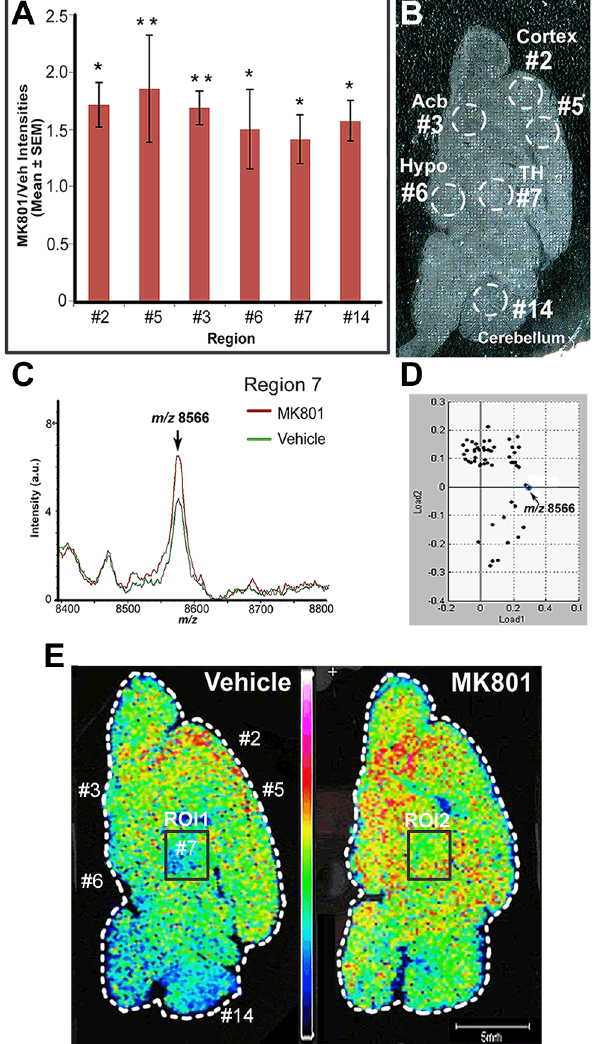
Figure 3. Elevated level of the m/z 6718 ion quantified by the strategy combining MS profiling and imaging. A) The ratios of the intensities of the ion at m/z 6718 in the profiling spectra of specific regions, regions # 1, # 2, # 5, # 9, # 7 and # 14, where the ion was concentrated. The averaged intensities and p-values were calculated by ClinProTools and manually confirmed. *, p , 0.05; **, p , 0.01, unpaired student’s t-test. (B) An optical image of a rat brain section washed after MSI experiments. (C) The m/z 6718 ion was up-regulated in the averaged MSI spectrum of the olfactory bulbs, ROI 1 and ROI2, of the rat brain section treated with vehicle and MK801 as shown in (E). (D) A loading plot of ROI 1 and ROI 2 analyzed by ClinProTools. The m/z 6718 ion was shown to contribute significantly in differentiating the two ROIs in Load 2. (E) MS images of the ions at m/z 6718 for the vehicle and the MK801-treated rat brain sections. The m/z 6718 ion was more concentrated in the olfactory bulb, cortex, thalamus (TH) and cerebellum regions in the MK801-treated section compared to the vehicle-treated one. doi:10.1371/journal.pone.0092831.g003 fulfilled by the conventional fractionation, which helped eliminat- ing ion suppression effects, reducing sample complexity and thus increasing the dynamic range of the analysis. The rat brains were pooled and fractionated in RP HPLC to concentrate the targeted proteins and reduce the complexity arising from high abundance proteins of tissues. All fractions were then screened on MALDI- TOF/TOF with the aim to ascertain if the proteins of interest accurate masses provided by this high-end instrument were then